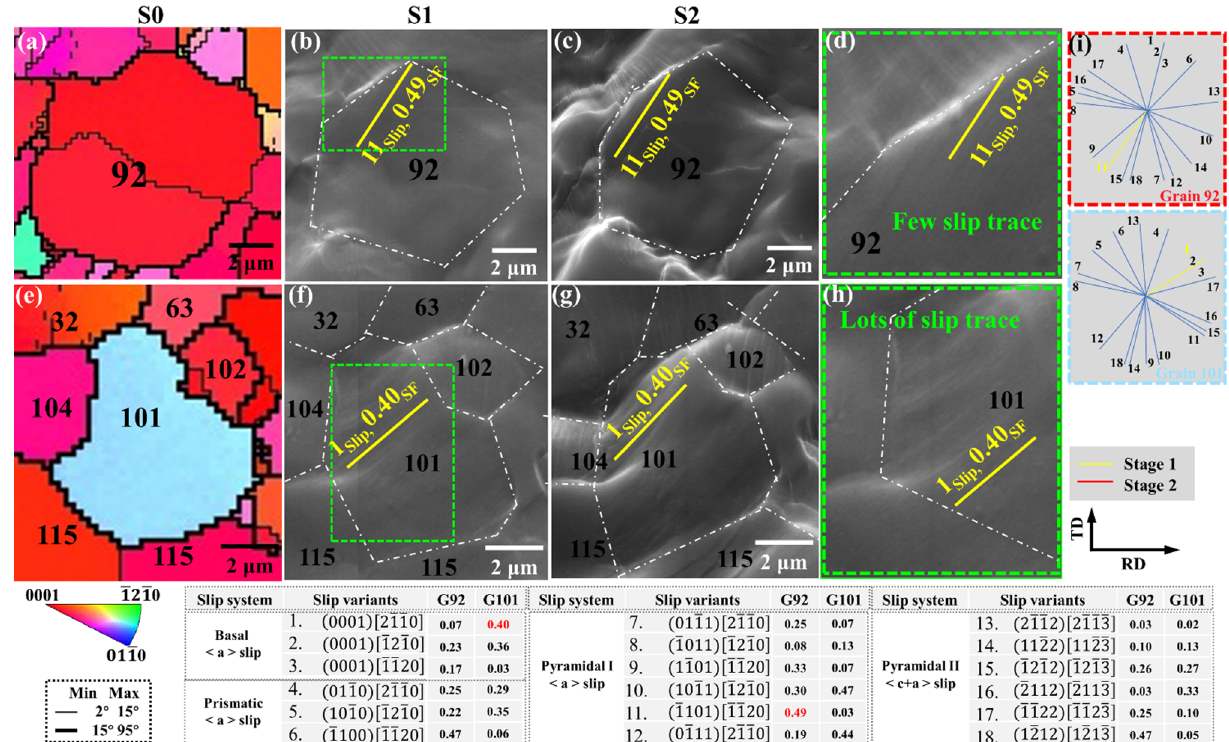
Figure 7. The plastic behavior of basal plane-oriented and non-basal plane-oriented grains during uniaxial stretching: ( a , e ) IPF images and ( b – d , f – h ) SEM images at different strain stages, ( i ) Slip traces for potential slip systems, with active slip systems highlighted.